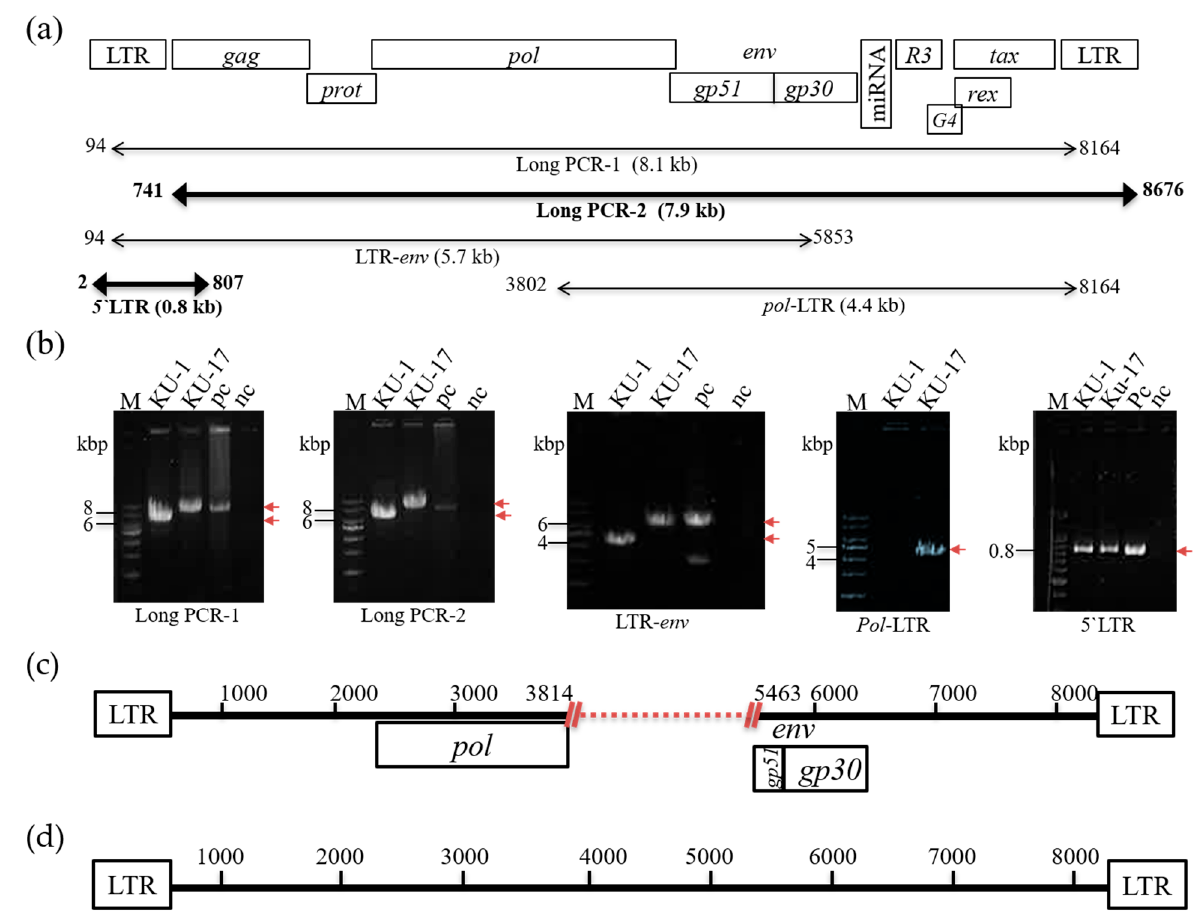
Figure 2. Schematic presentation of PCR amplification and sequencing of BLV provirus in BLSC-KU1 and BLSC-KU17 cell lines. ( a ) Proviral structure of BLV in the FLK-BLV subclone pBLV913, complete genome (accretion number: EF600696), primer pairs, and the lengths of expected PCR products. Numbers indicate the start and end sites of primer binding sites; numbers under the bar with kbp indicate the length of expected PCR products; and dark bars indicate the PCR products subjected to sequencing. ( b ) Electrophoresis images of amplified PCR products. M, molecular weight marker (1 kbp and 100 bp DNA Ladder), numbers with lines indicate the size of the DNA ladder, and arrows in red indicate the target PCR product; nc, no-template DNA-negative control (water substituted for DNA template); pc. DNA from FLK-BLV cell line. ( c , d ) Visualization of proviral sequences results for BLSC-KU1 ( c ) and BLSC-KU17 ( d ). Numbers denote the positions of complete sequences of the FLK-BLV subclone pBLV913. Dot with red indicates the deleted